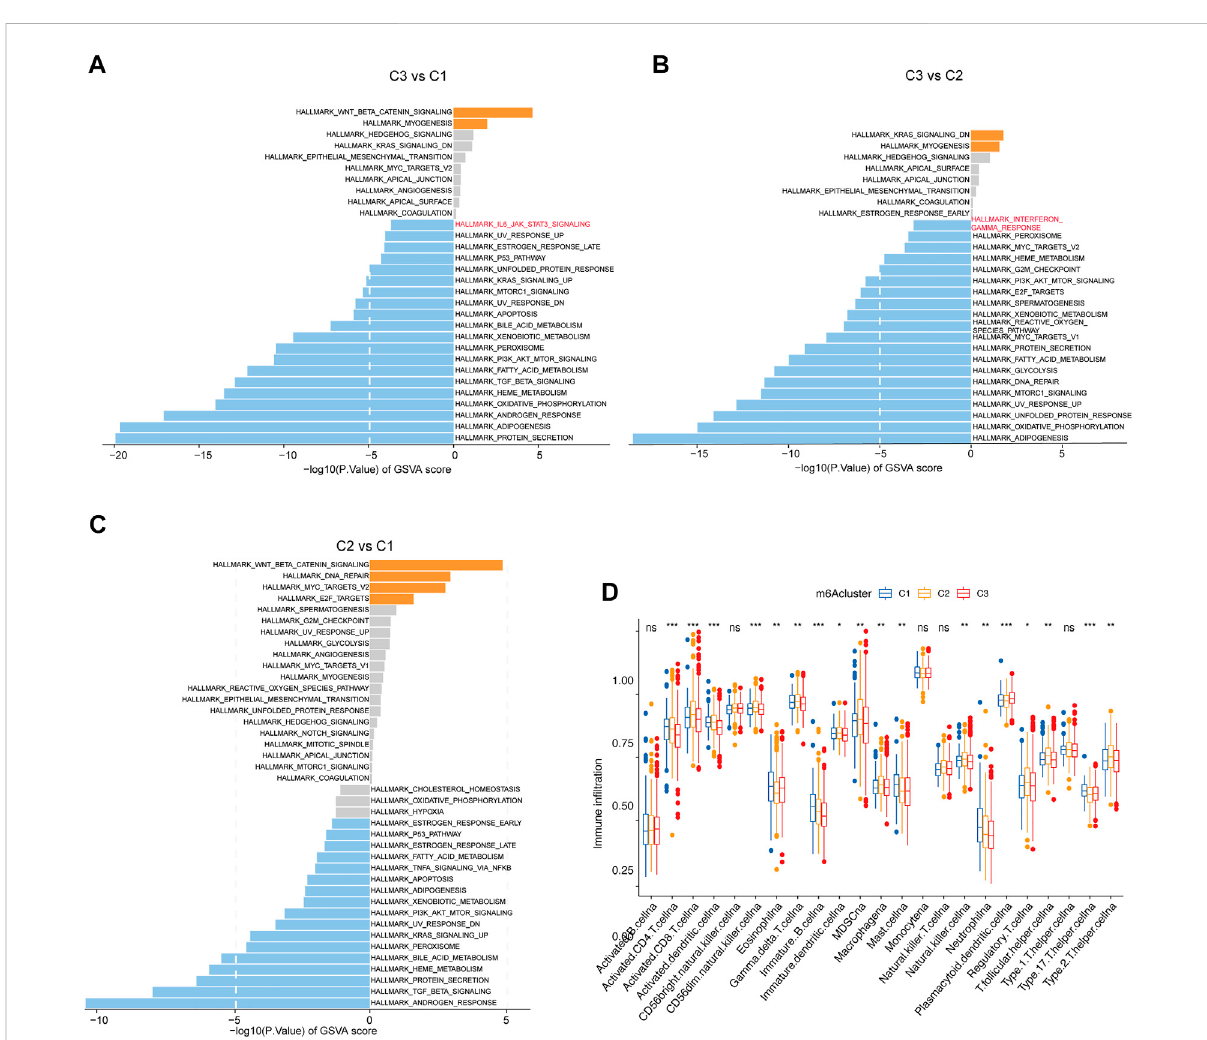
FIGURE 3 Immune pro fi les among the different m6A methylation modi fi cation patterns. (A – C) GSVA enrichment analysis shows the activation states of biological pathways in the three clusters. The biological processes are visualized with the bar plot: orange represents activated pathways; blue represents inhibited pathways. (D) Fraction of tumor-in fi ltrating lymphocyte cells in three m6A clusters using the ssGSEA algorithm. Within each group,thescattereddotsrepresentedTMEcellexpressionvalues.Thethicklinerepresentedthemedianvalue.Thebottomandtopoftheboxes were the 25th and 75th percentiles, respectively (interquartile range). The statistical difference between the three gene clusters was compared through the Kruskal – Wallis H test. * p < 0.05; ** p < 0.01; *** p <